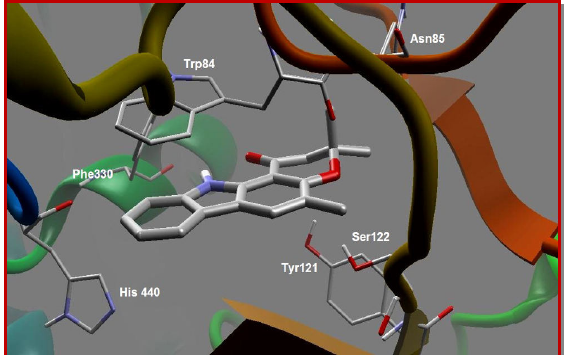
Figure 2: Molecular binding mode of euchrestifoline (Ecf) in- side active site of AChE. Hydrogen atoms except polar ones are omitted for